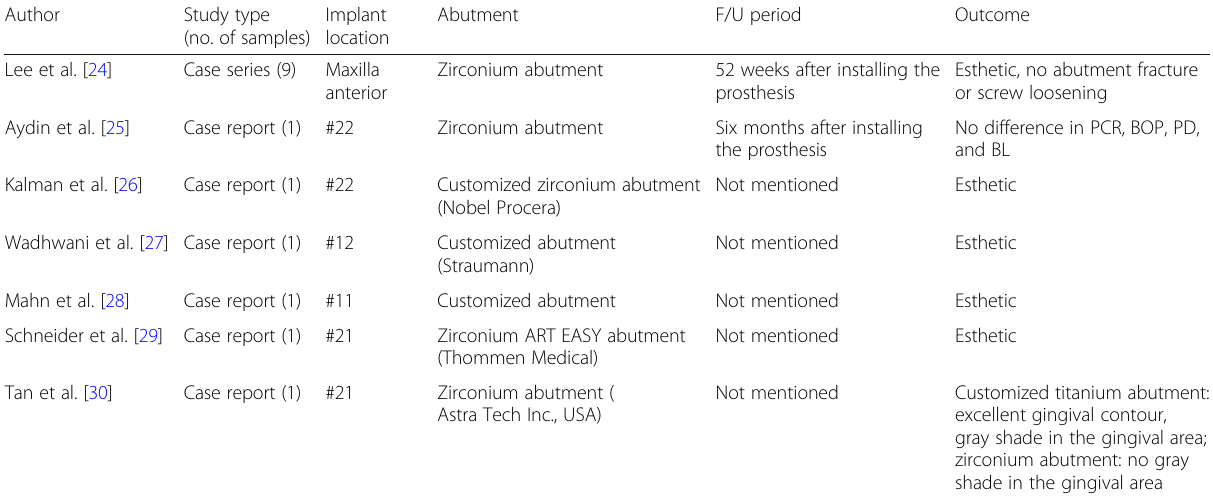
Table 7 Summary of international studies with evidence level 4